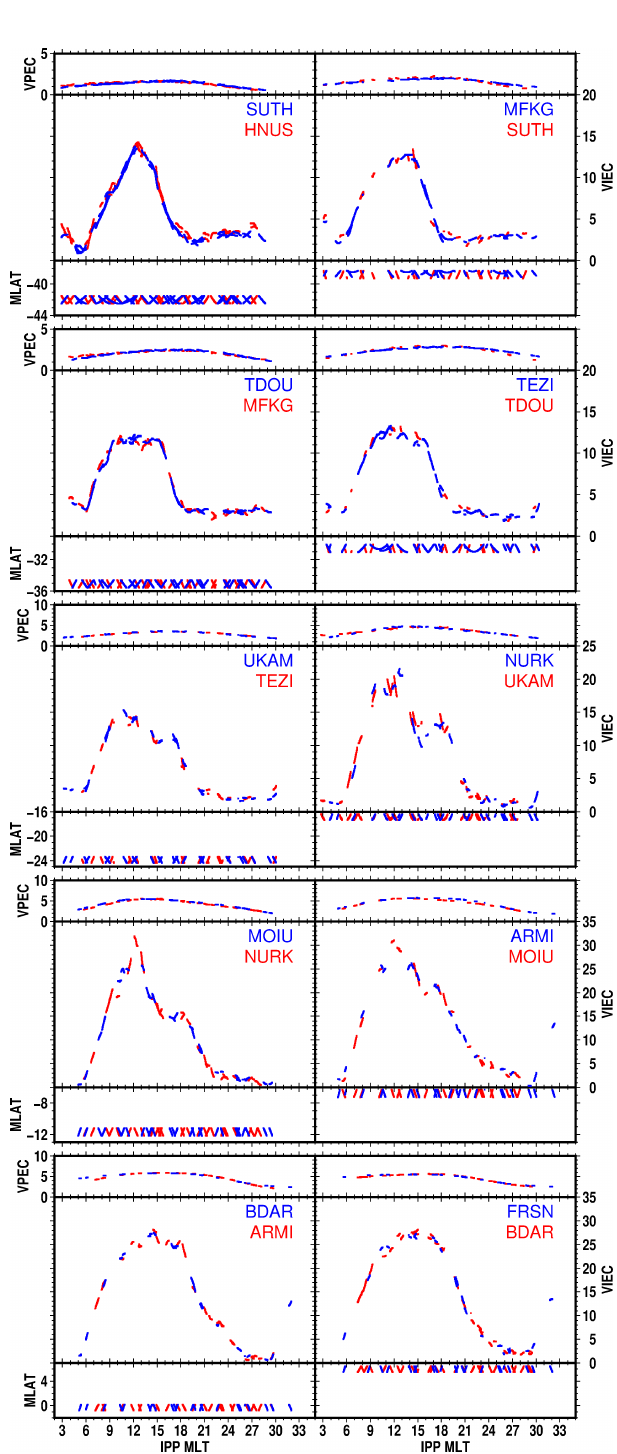
Figure 4. The TEC comparisons for overlapping 1 ◦ magnetic lat- itude bands, for the determination of the plasmasphere baselines. The vertical plasmaspheric electron content (VPEC) is displayed in the top of each panel for each